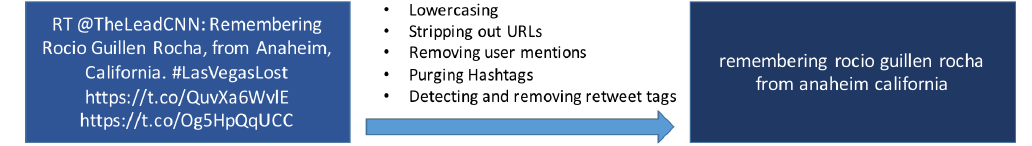
Figure 2. An illustration of pre-processing for a real-world